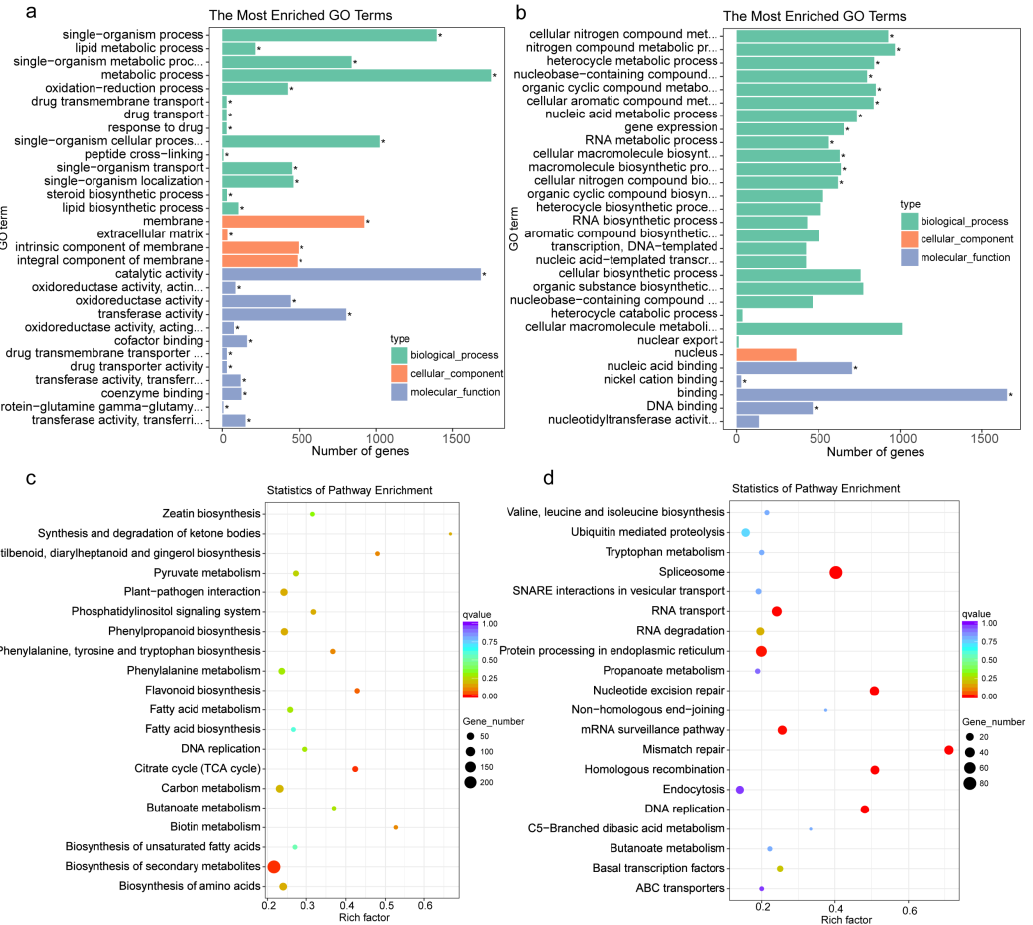
Figure 3. GO and KEGG analysis of common DEGs at different times in response to cut-wounding. ( a ) and ( b ), GO terms of the functional categorization of up- and down-regulated DEGs of all common DEGs at different time in response to cut-wounding, respectively; Significantly enriched GO terms are indicated by * for a p -value less than and equal to 0.05; ( c ) and ( d ), KEGG classification of the functional categorization of up- and down-regulated DEGs of all common DEGs at different times in response to cut-wounding, respectively.